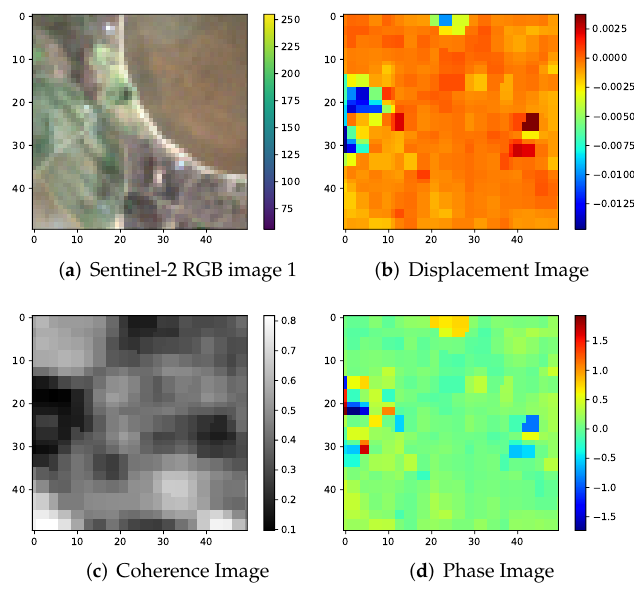
Figure 19. False-positive blob of crops in Pretoria Rural. Figure 20 illustrates the DInSAR processed phase, coherence, and displacement images with the corresponding Sentinel-2 RGB image of a false-positive blob that was caused by trees (vegetation), causing undesirably low coherence at the coordinates ( − 26.1241380519143, 28.0437540461661) in an urban area in Hyde Park, Gauteng, South Africa. The decision boundary between true-positive blobs (used as positive samples in binary classification) and false-positive blobs (used as negative samples for binary classification) is not distinctly defined, as both can occur when there is undesirably low coherence and also when there is good